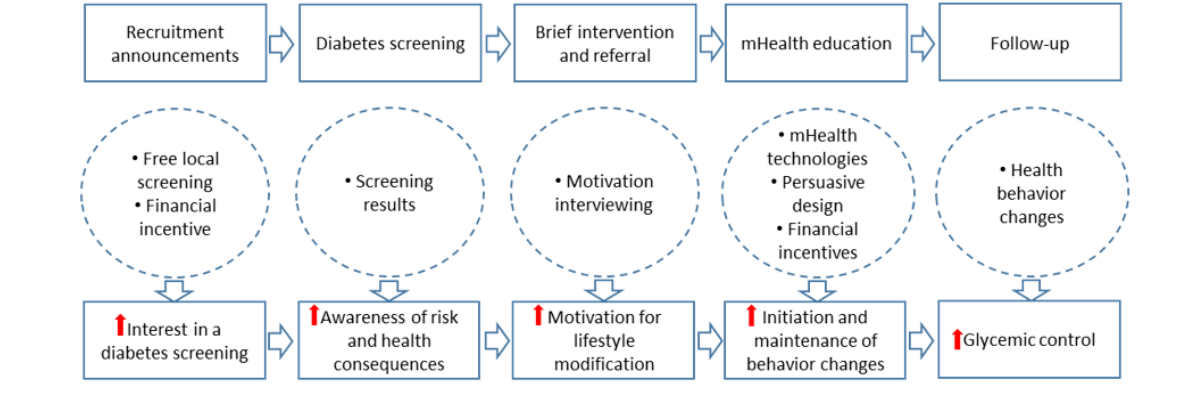
IncentivesReferral to treatmentBrief interventionScreening result No referralBrief education by a